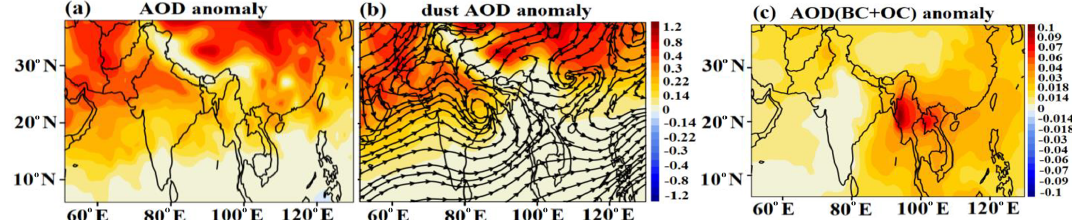
Figure 3. Distribution of ECHAM6–HAMMOZ-simulated anomalies of (BMaeroon − BMaerooff) (a) AOD, (b) dust AOD, and (c) BC- AOD and OC-AOD, together, averaged for spring 2013. Streamlines in (b) indicate wind anomalies at 900hPa (BMaeroon − BMaerooff).